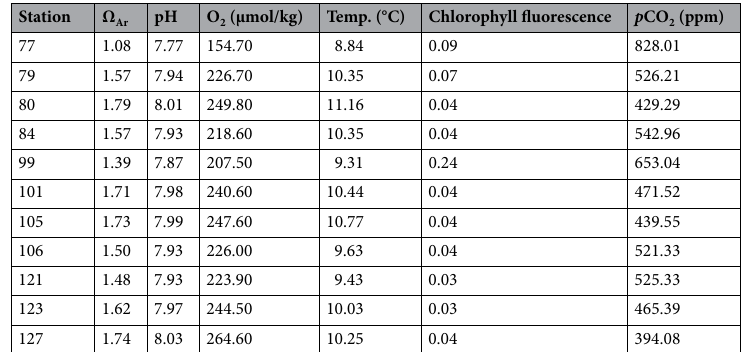
Table 1. Oceanographic variables measured at the eleven stations in the California Current Ecosystem from which the pteropods were sampled. Values were averaged over the upper 100 m of the water column. The locations of the stations are shown in Fig. 1a. Aragonite saturation (Ω Ar ), oxygen (O 2 ), temperature